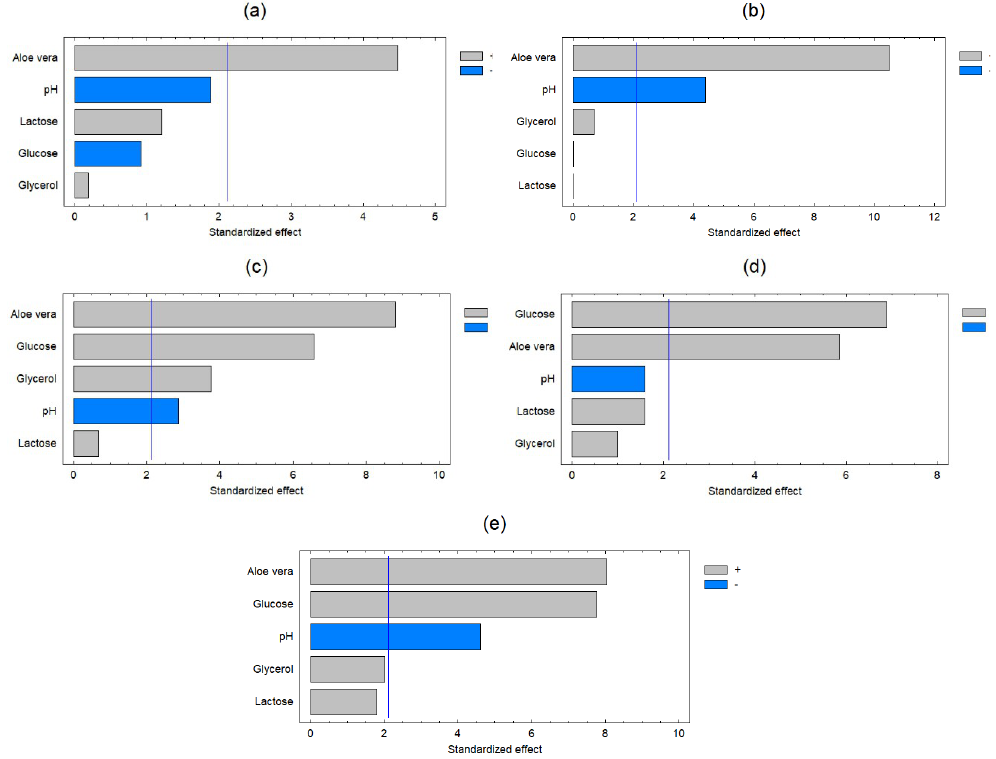
Figure 3. Pareto charts of the standardized effect of different factors on the viability of the TEP6 bacteria incorporated into films and stored for 28 days, evaluated on days 0 ( a ), 7 ( b ), 14 ( c ), 21 ( d ) and 28 ( e ).